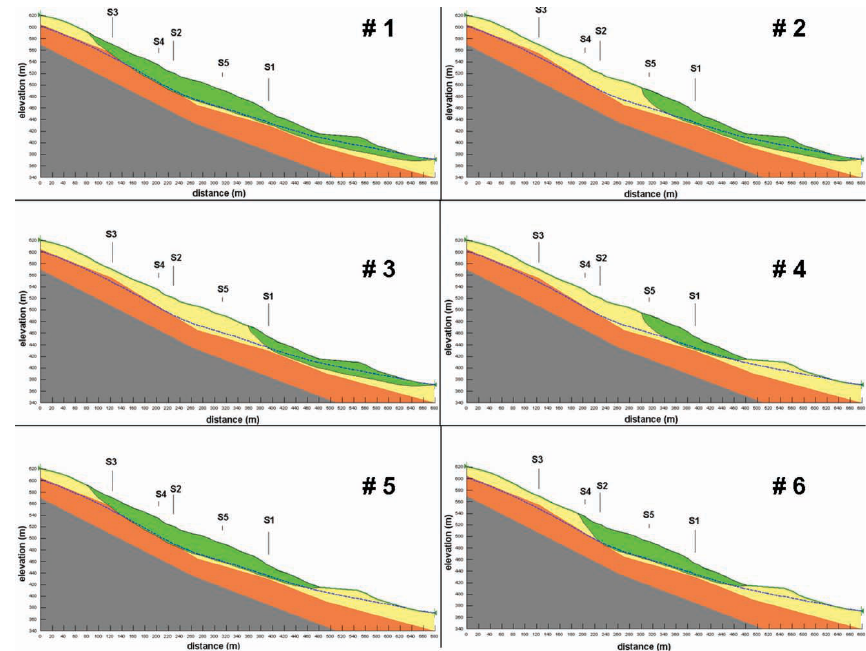
Fig. 5. Scheme of the slope adopted for the limit equilibrium back-analyses (see text for details). The considered three layers, the six main landslide bodies, and the locations of the boreholes are